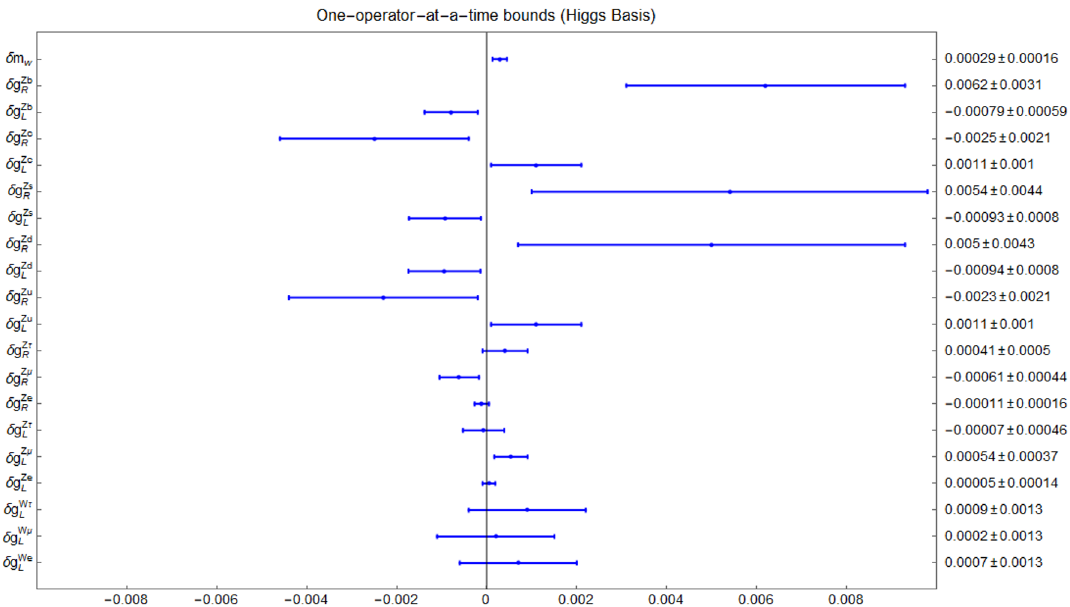
ables (table 1 and table 2), LHC A FB data (table 3) and D0 A FB data [41], when considering one Higgs-basis operator at a time.